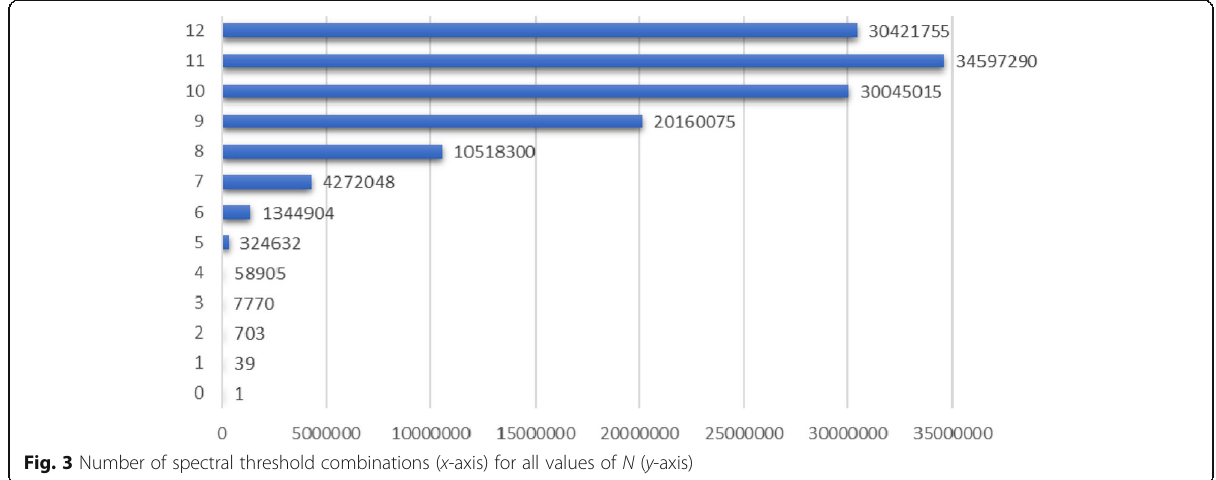
i = 1: N − 1 sub-bands. All EEG filters are designed as